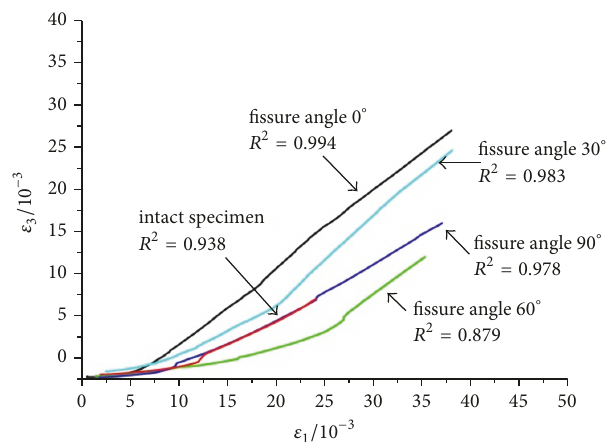
Figure 4: Relationship of the circumstantial strain and axial